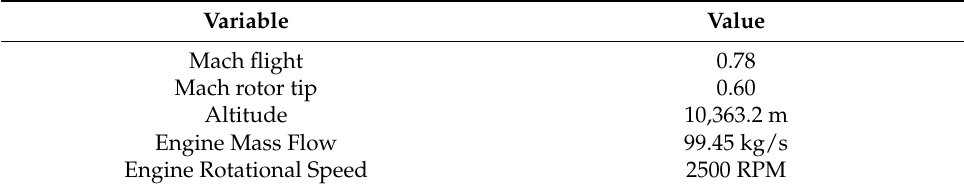
Figure 3. Illustration of Rotor–Stator Interaction (RSI) noise mechanism. Table 1. Aerodynamic and engine